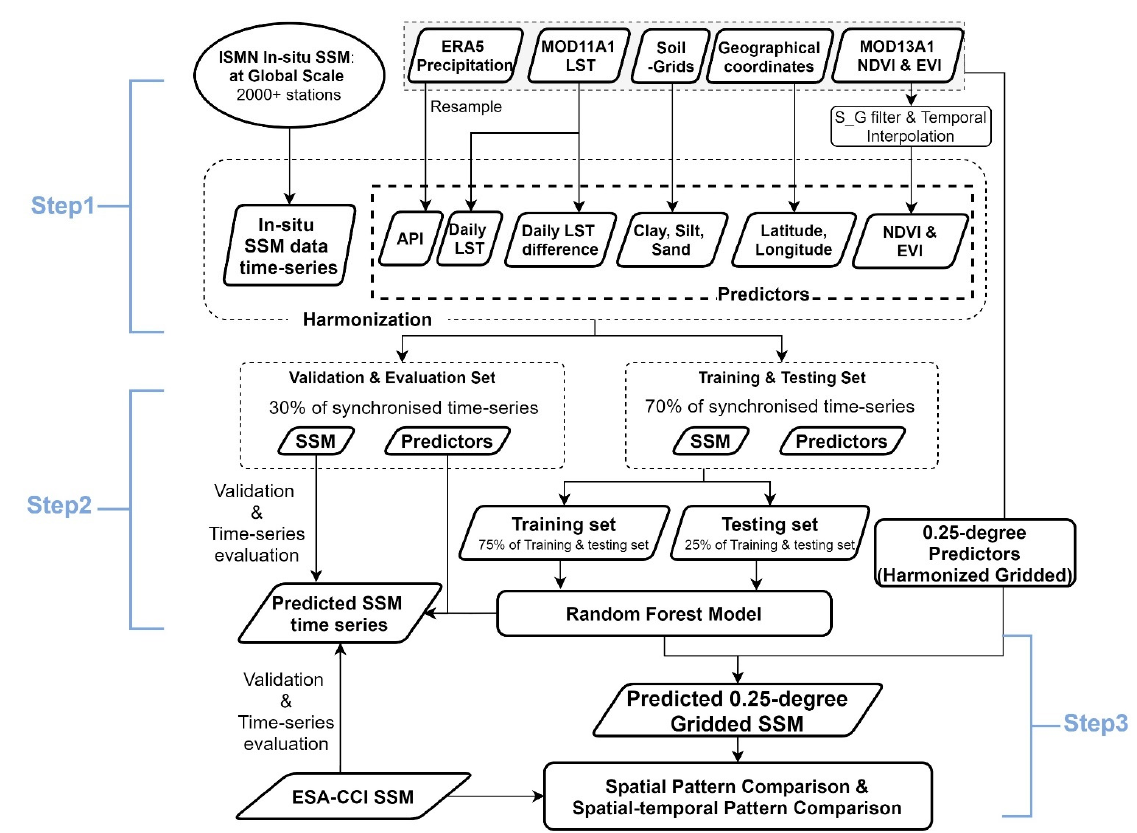
Figure 2. Flowchart of methodology to derive prediction model for SSM and derive SSM maps.